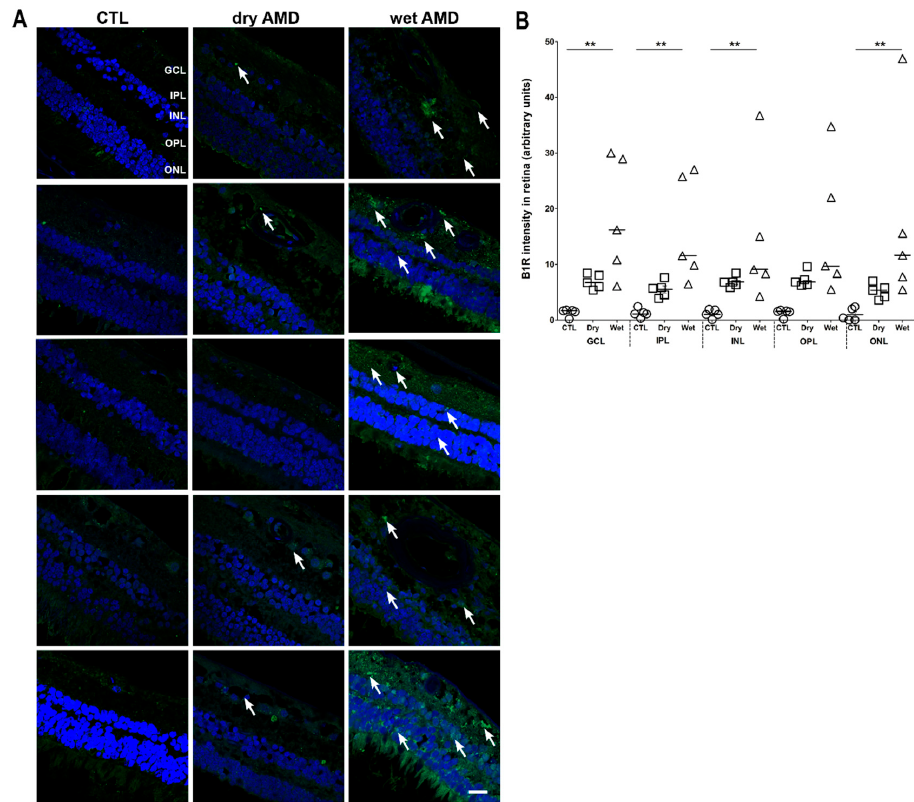
Figure 2. B1R immunoreactivity in human retinae. ( A ) Microphotographs show B1R in five human control (left panel), five dry (middle panel) and five wet (right panel) AMD retinae. B1R (green) was not detected in control retina, and mostly expressed in the GCL of the dry AMD retinae (arrows). In the wet AMD, B1R was highly detected in most retinal layers. Sections are all counterstained for 4 ′ ,6-diamidino-2-phenylindole (DAPI; blue), which labels cell nuclei. Images were obtained at 40×. Scale bar: 20 µ m. ( B ) Semi-quantification of B1R fluorescence intensity on all the surface area of each retinal layer from five dry AMD, five wet AMD and five controls showing a significant increase (** p < 0.005) of B1R labeling intensity in the wet AMD, compared to the control retina. Data represent mean intensity ± SEM after subtraction of the background intensity. CTL: control (O), Dry: dry AMD ( (cid:3) ), Wet: wet AMD ( (cid:52) ), GCL: ganglion cell layer, IPL: inner plexiform layer, INL: inner nuclear layer, OPL: outer plexiform layer, ONL: outer nuclear